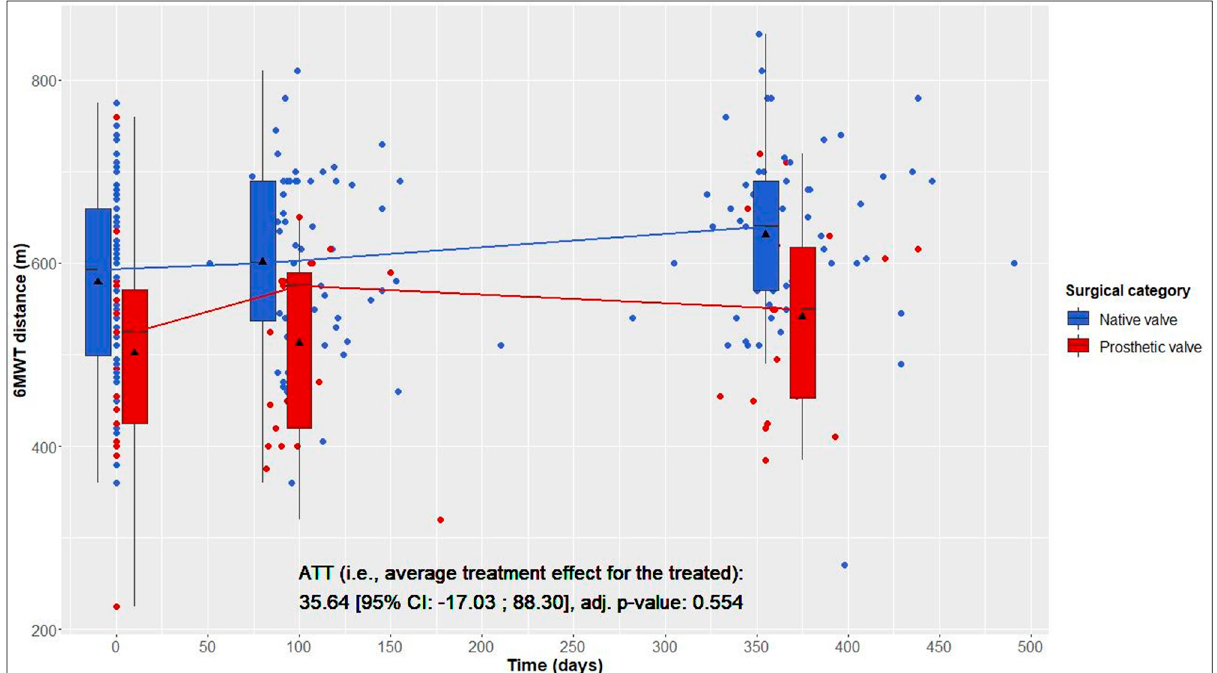
Figure 1. Six-minute walk test (6MWT) distance over time in native valve vs. prosthetic valve patients; boxes and whiskers indicate medians, IQRs, minima and maxima (raw data); triangles indicate means (raw data); medians are connected to show time trend; displayed p -value corresponds to ATT testing after inverse probability of treatment weighting.